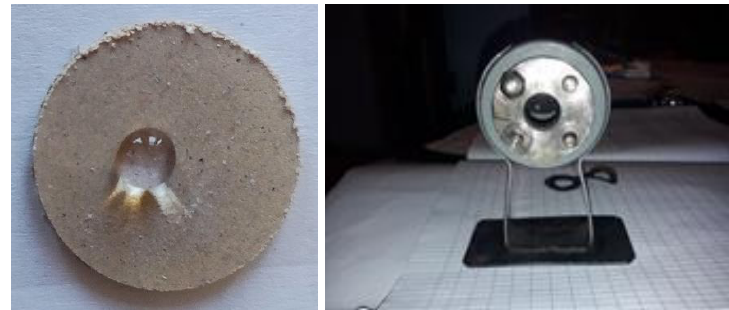
Figure 1. Hydrophobicity testing: a) water drop test and b) real conditions